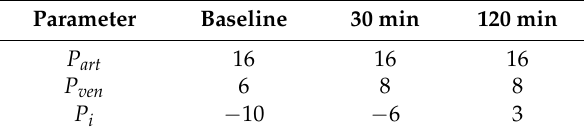
Table 1. This table illustrates the input pressure parameters (cmH 2 O) for the modelled ACU networks. Note the increase in peri-microvascular interstitial pressure ( P i ) on developing interstitial edema [3]. Parameter